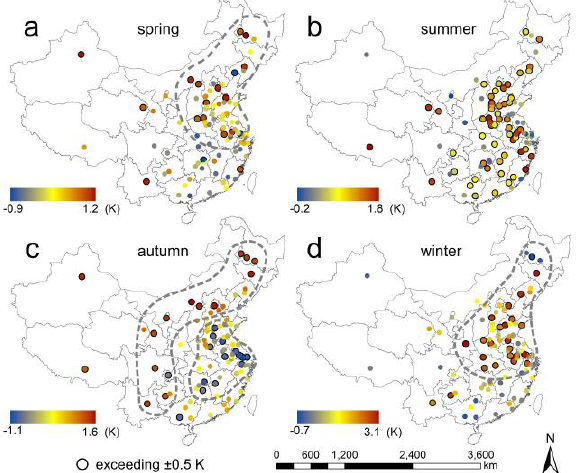
Figure 2. Spatial pattern of ∆SUHII (K) during the day for the four seasons. Regions where most cities have a significant ∆SUHII are highlighted with grey dotted curve